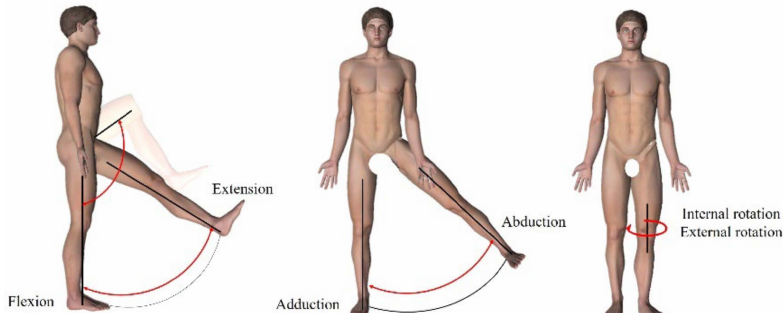
Figure 3. Motion range of human hip joint.